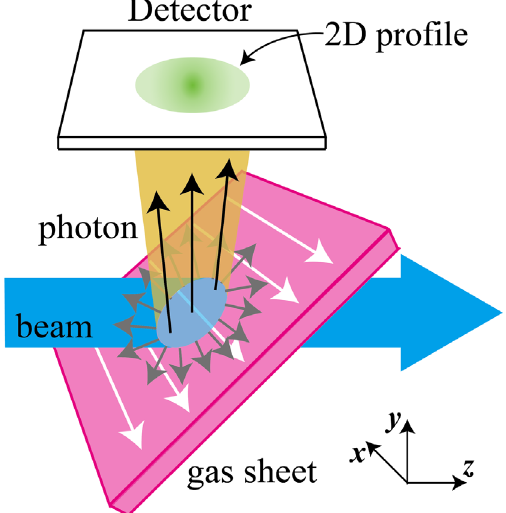
FIG. 1. A schematic diagram of a gas sheet beam profile monitor. The density distribution of the injected gas is concen- trated like a thin sheet to enable measurements of the transverse beam profile in two dimensions without significant increase of the beam line gas